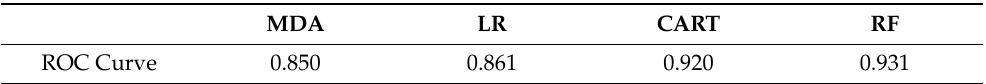
Table 5. Models’ evaluation using the Receiver Operating Characteristic (ROC) curve